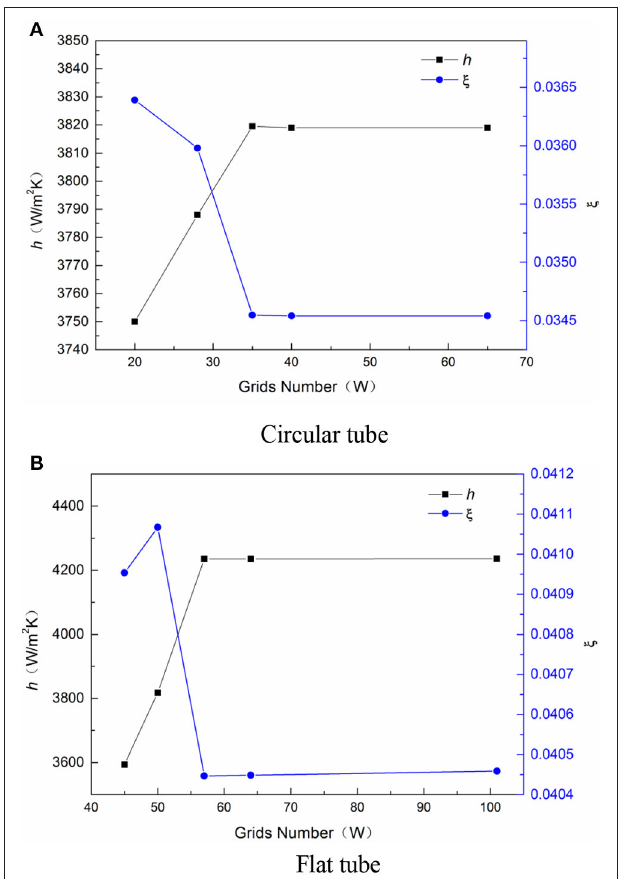
FIGURE 5 | Grids Independent verification.